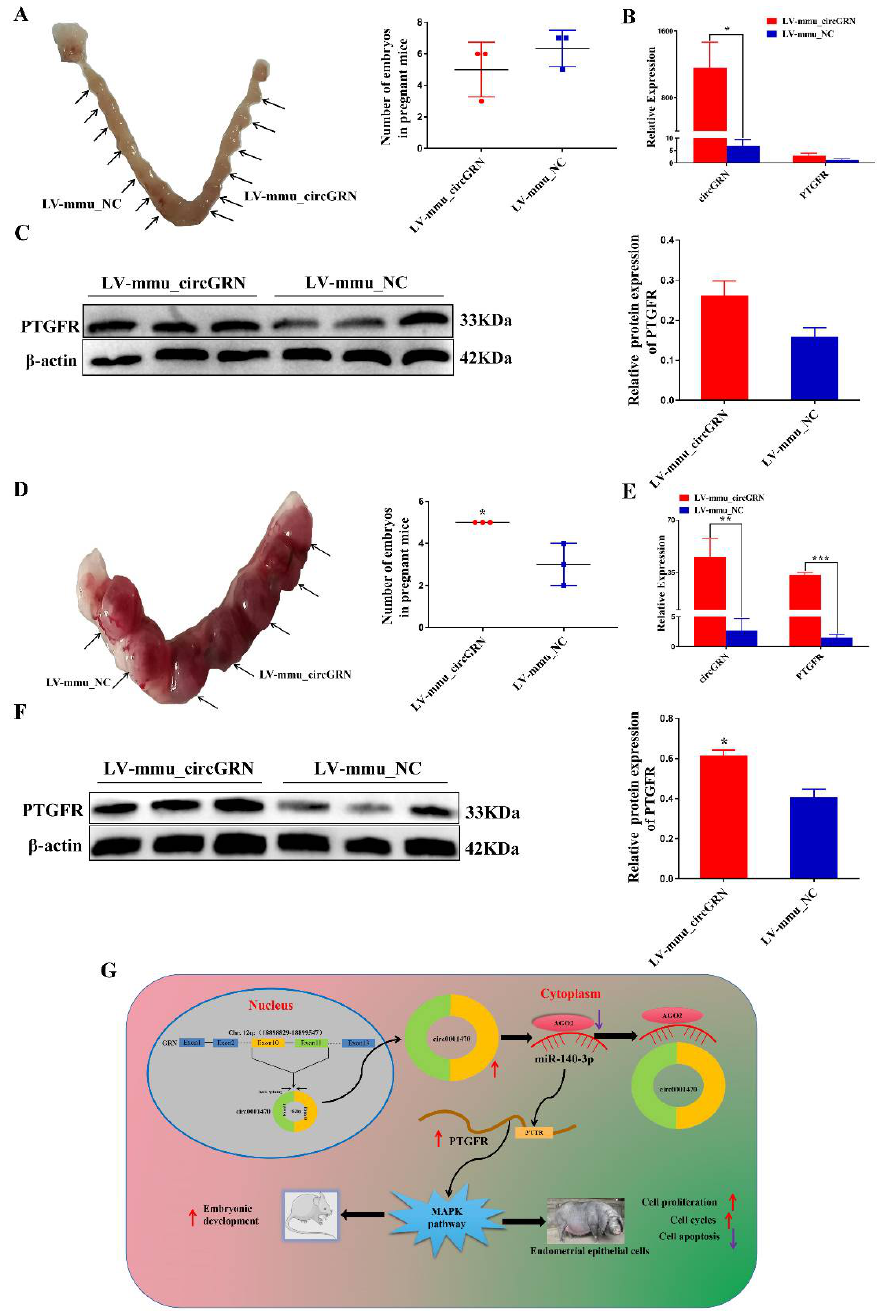
Figure 8. Analysis of mmu-circGRN function in mice during implantation and embryo development. ( A ) Comparison of the number of implantation sites between LV-mmu_NC injected uterine horn ( left ) and LV-mmu_circGRN injected uterine horn ( right ) on day five of pregnancy (n = 3). ( B ) The relative expression of circGRN and PTGFR in the pregnant mice embryos at the implantation stage (n = 3). ( C ) Relative expression levels of PTGFR proteins in the pregnant mice embryos at the implantation stage (n = 3). ( D ) Comparison of the number of embryonic development sites between LV-mmu_NC injected uterine horn ( left ) and LV-mmu_circGRN injected uterine horn ( right ) on day 10 of pregnancy (n = 3). ( E ) The relative expression levels of circGRN and PTGFR in the developing endometrium of pregnant mice (n = 3). ( F ) The relative expression levels of PTGFR proteins in the developing endometrium of pregnant mice (n = 3). ( G ) The hypothetical regulation model for circ0001470/miR-140-3p/PTGFR. Data are presented as the mean ± SD for three subjects. * p < 0.05, ** p < 0.01, *** p <